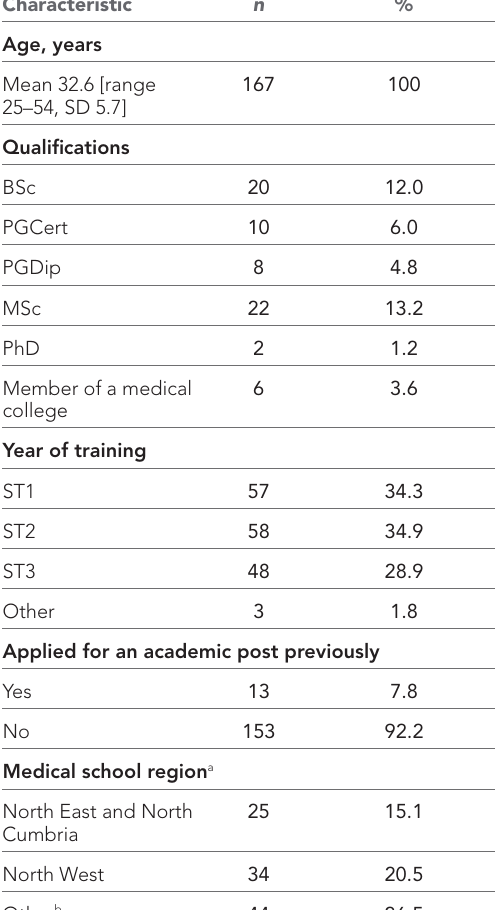
Table 1 Characteristics of trainee